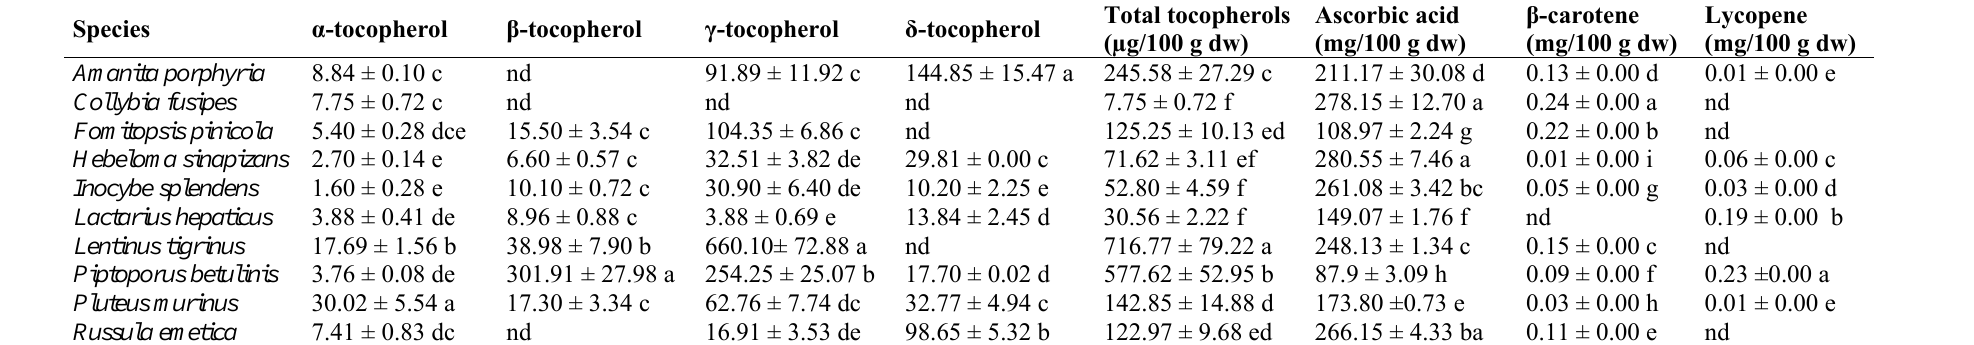
Table 3. Biomolecules (vitamins and carotenoids) with antioxidant